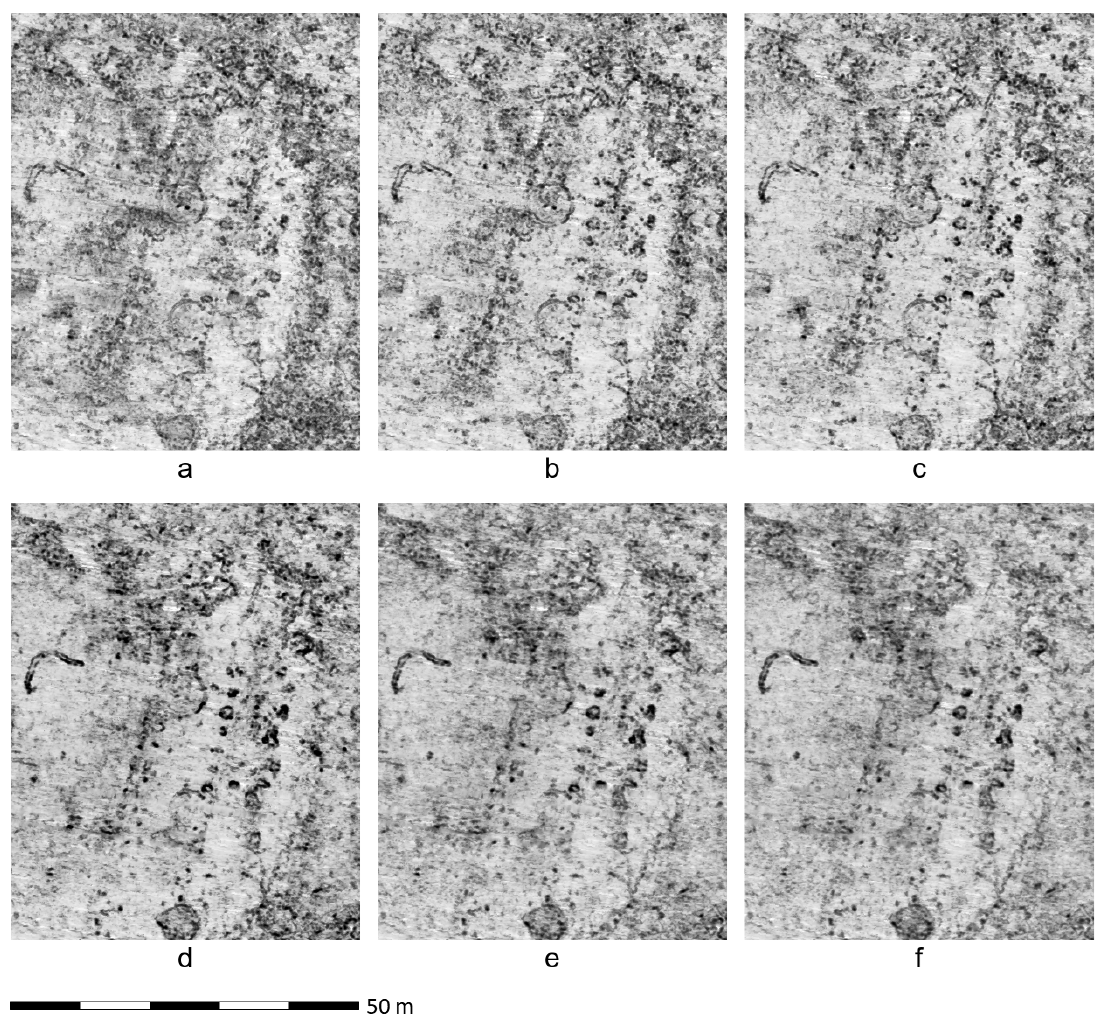
Figure 10. Coherence computation using different cross-correlation lengths: ( a ) 1 ⁄ 4 wavelength, ( b ) 1 ⁄ 2 wavelength, ( c ) 1 wavelength, ( d ) 2 wavelengths, ( e ) 3 wavelengths, ( f ) 4